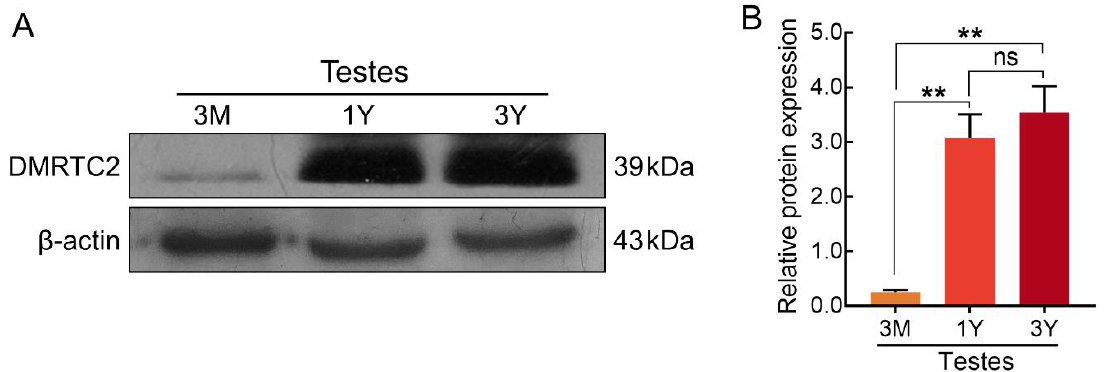
Figure 6. Temporal expression patterns of DMRTC2 protein during testicular development. ( A ) Western blot analysis for DMRTC2 protein. ( B ) Relative expression level of DMRTC2 protein. Data show means ± SD from eight independent experiments. **: p < 0.01, *: p < 0.05, and ns: nonstatistical significance. 3 M: three months old, 1 Y: one year old, and 3 Y: three years old.